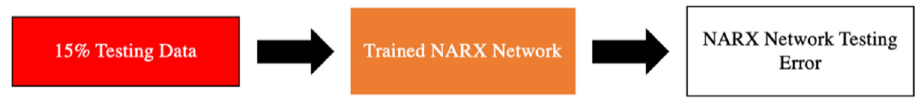
Figure 4. NARX Network testing phase using testing data (15% of all data).